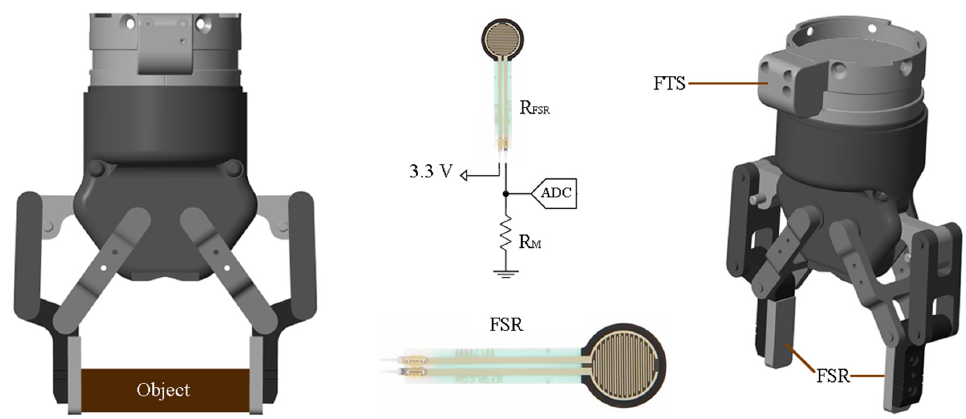
Figure 1. The model of the two-finger gripper in SimMechanics (MATLAB). Figure 2 is the architecture of the optimal fuzzy impedance controller, including three blocks: position control, force calculation, and optimal fuzzy impedance control.